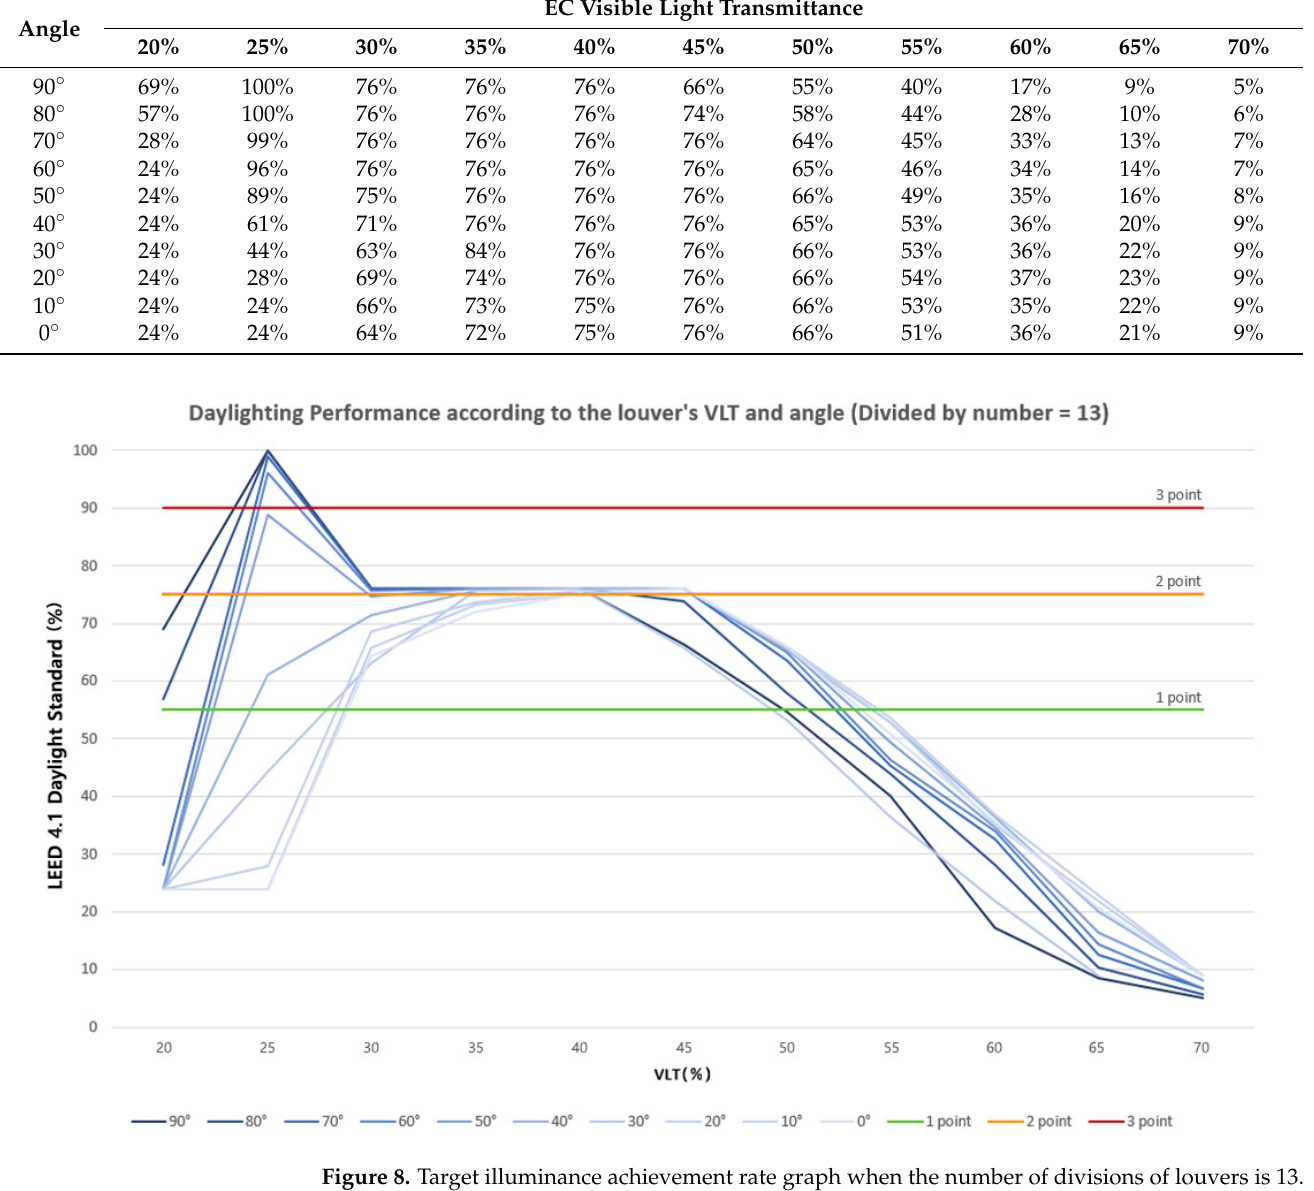
Table 8. Target illuminance achievement rates when the number of divisions of louvers is 14. Angle